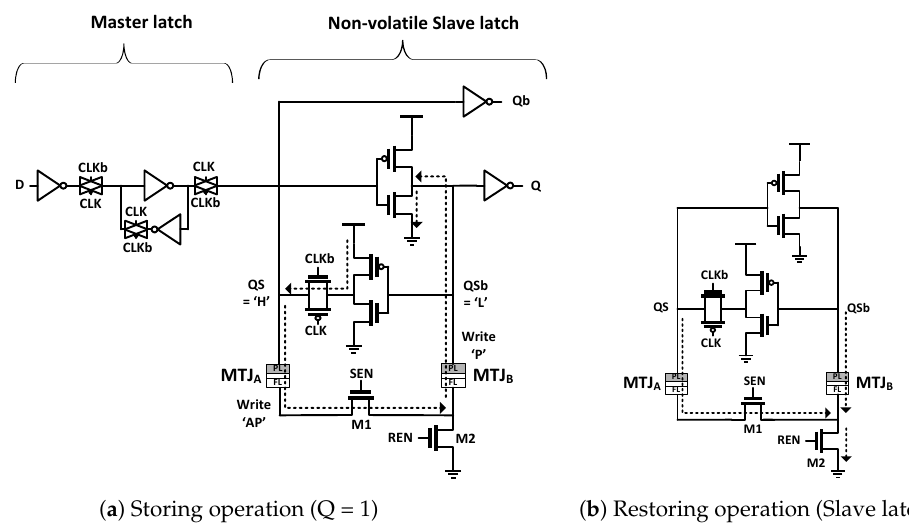
Figure 2. Schematic of the proposed current reutilization NVFF.